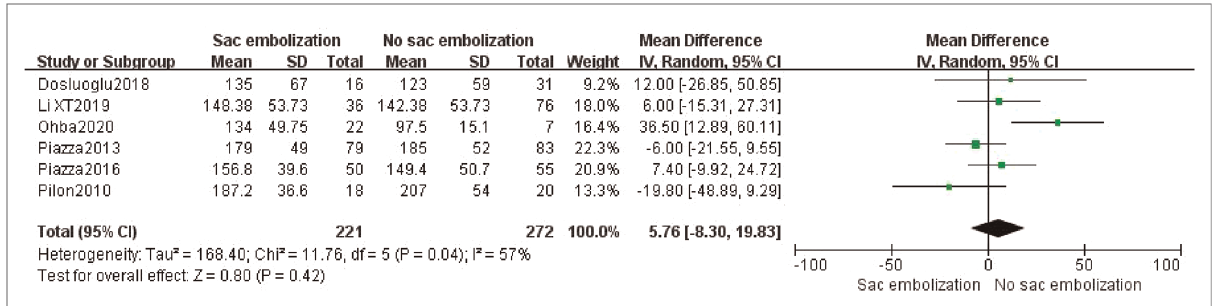
FIGURE 8 The time of operation in the embolization group compare with the non- embolization group.